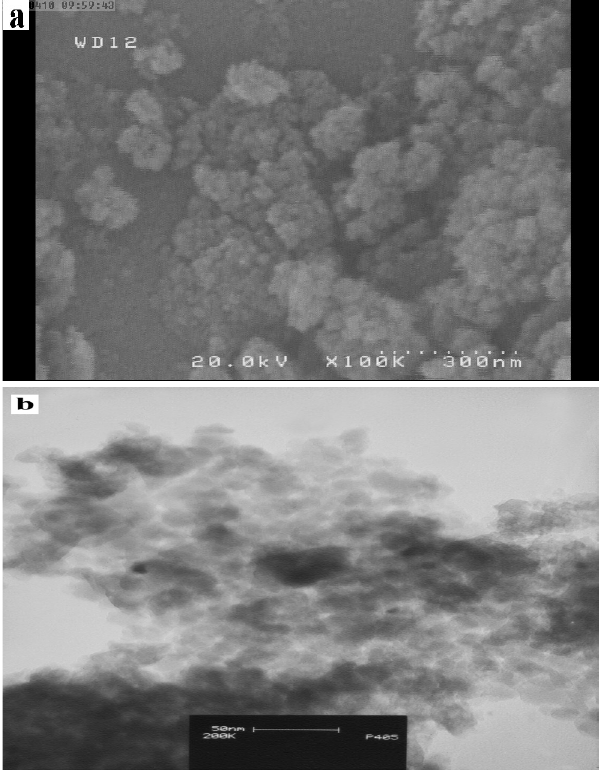
Fig. 2. FE-SEM photograph (Figure 2a) and TEM image (Figure 2b) of TiO